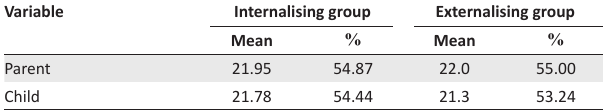
TABLE 5: The Strengths and Difficulties Questionnaire (SDQ) scores for all adolescents, and their parents.